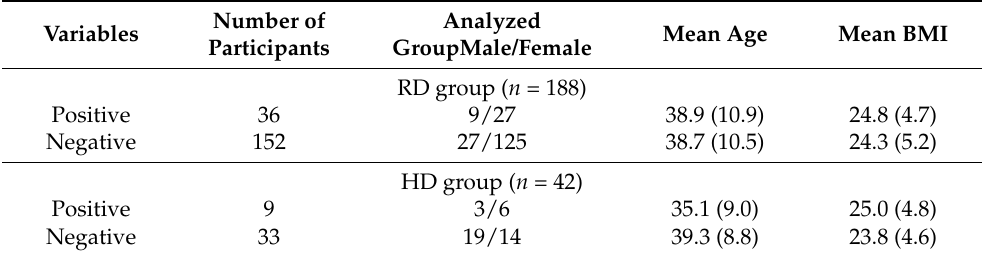
Table 1. Characteristic of